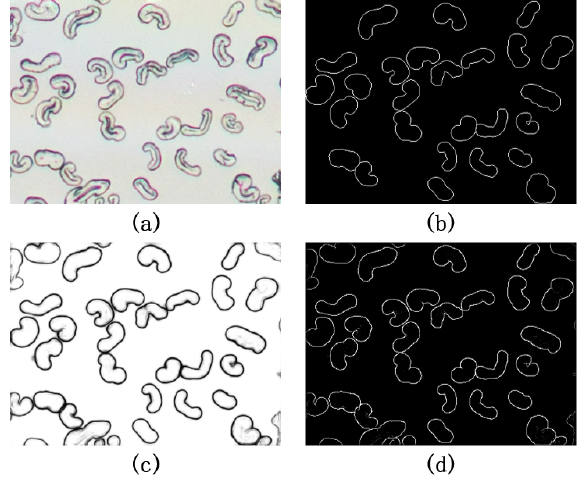
Figure 6. Edge detection of microscopic image of cotton fiber cross-section using RCF. ( a ) is the original image. ( b ) is the true edge of the manual annotation. ( c ) is output image of RCF. ( d ) is the edge of cross-sections image that is obtained by Non-Maximum Suppression (NMS).